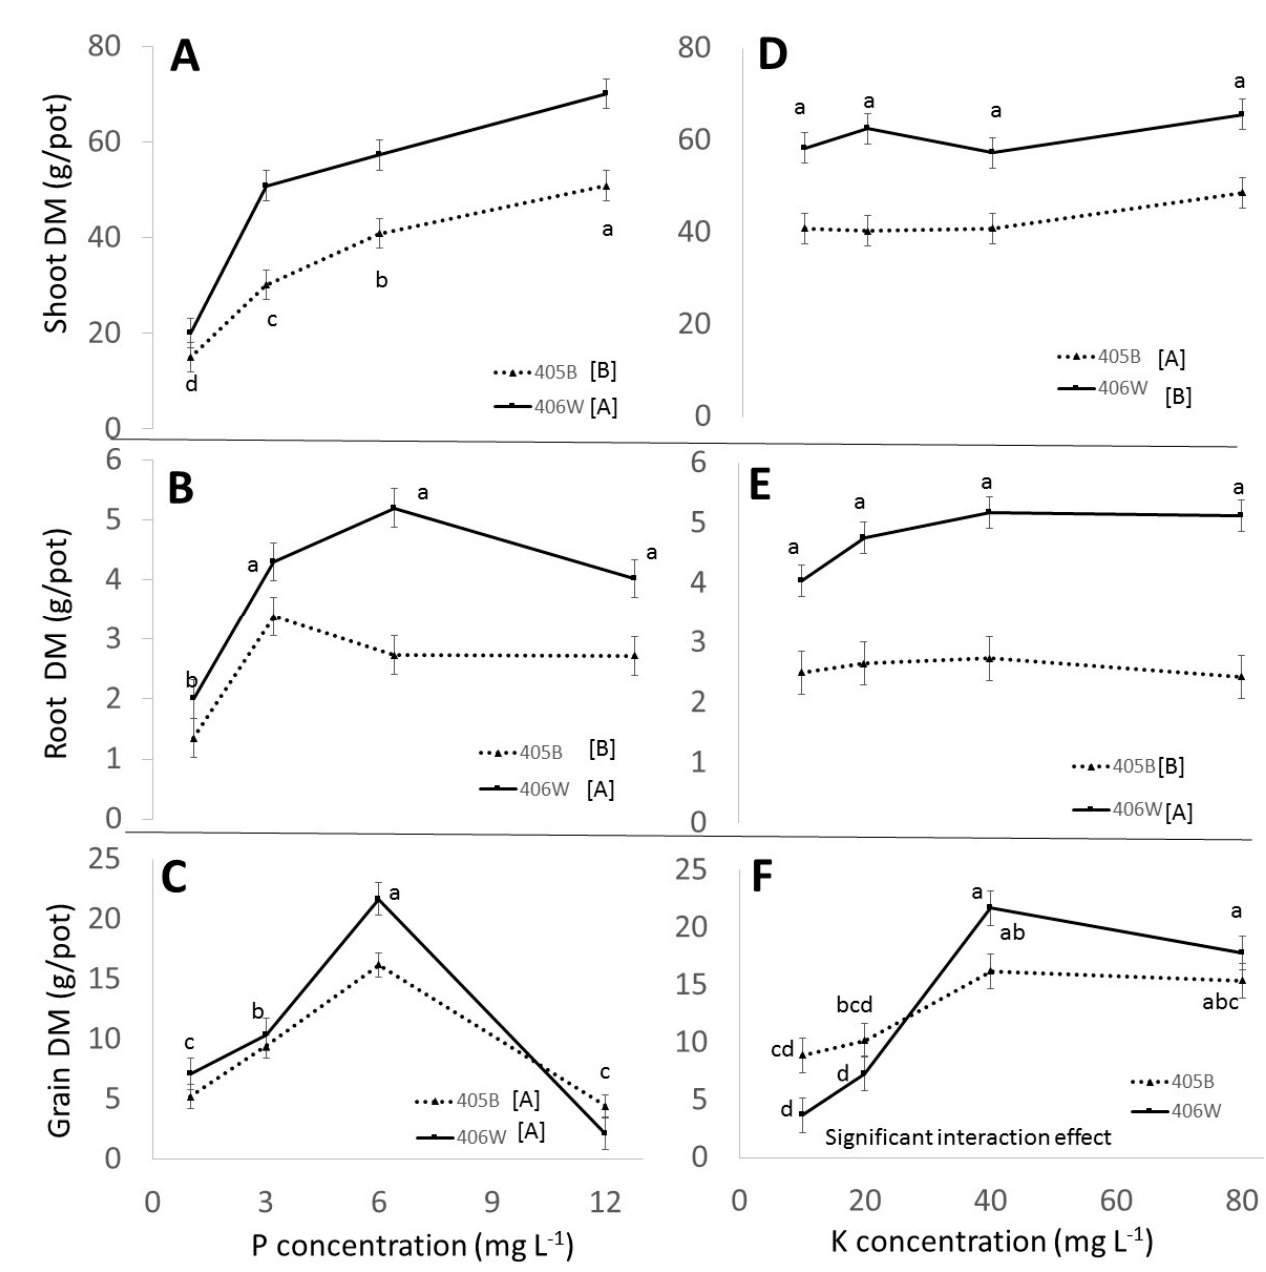
Figure 1. Shoot ( A ), root ( B ) and grain ( C ) dry matter at maturity in the winter pot experiment by P fertigation level, and Shoot ( D ), root ( E ) and grain ( F ) dry matter at maturity in the winter pot experiment by K fertigation level. Dashed line represents 405B genotype, and solid line represents 406W genotype. Different letters represent significant (<0.05) differences for main effects. Lower case letters adjacent to the trend line represent the results of the Tukey test for nutrient concentration averaged across genotypes, and capital letters adjacent to the legend represent the results of the Student- t test for the two different genotypes.